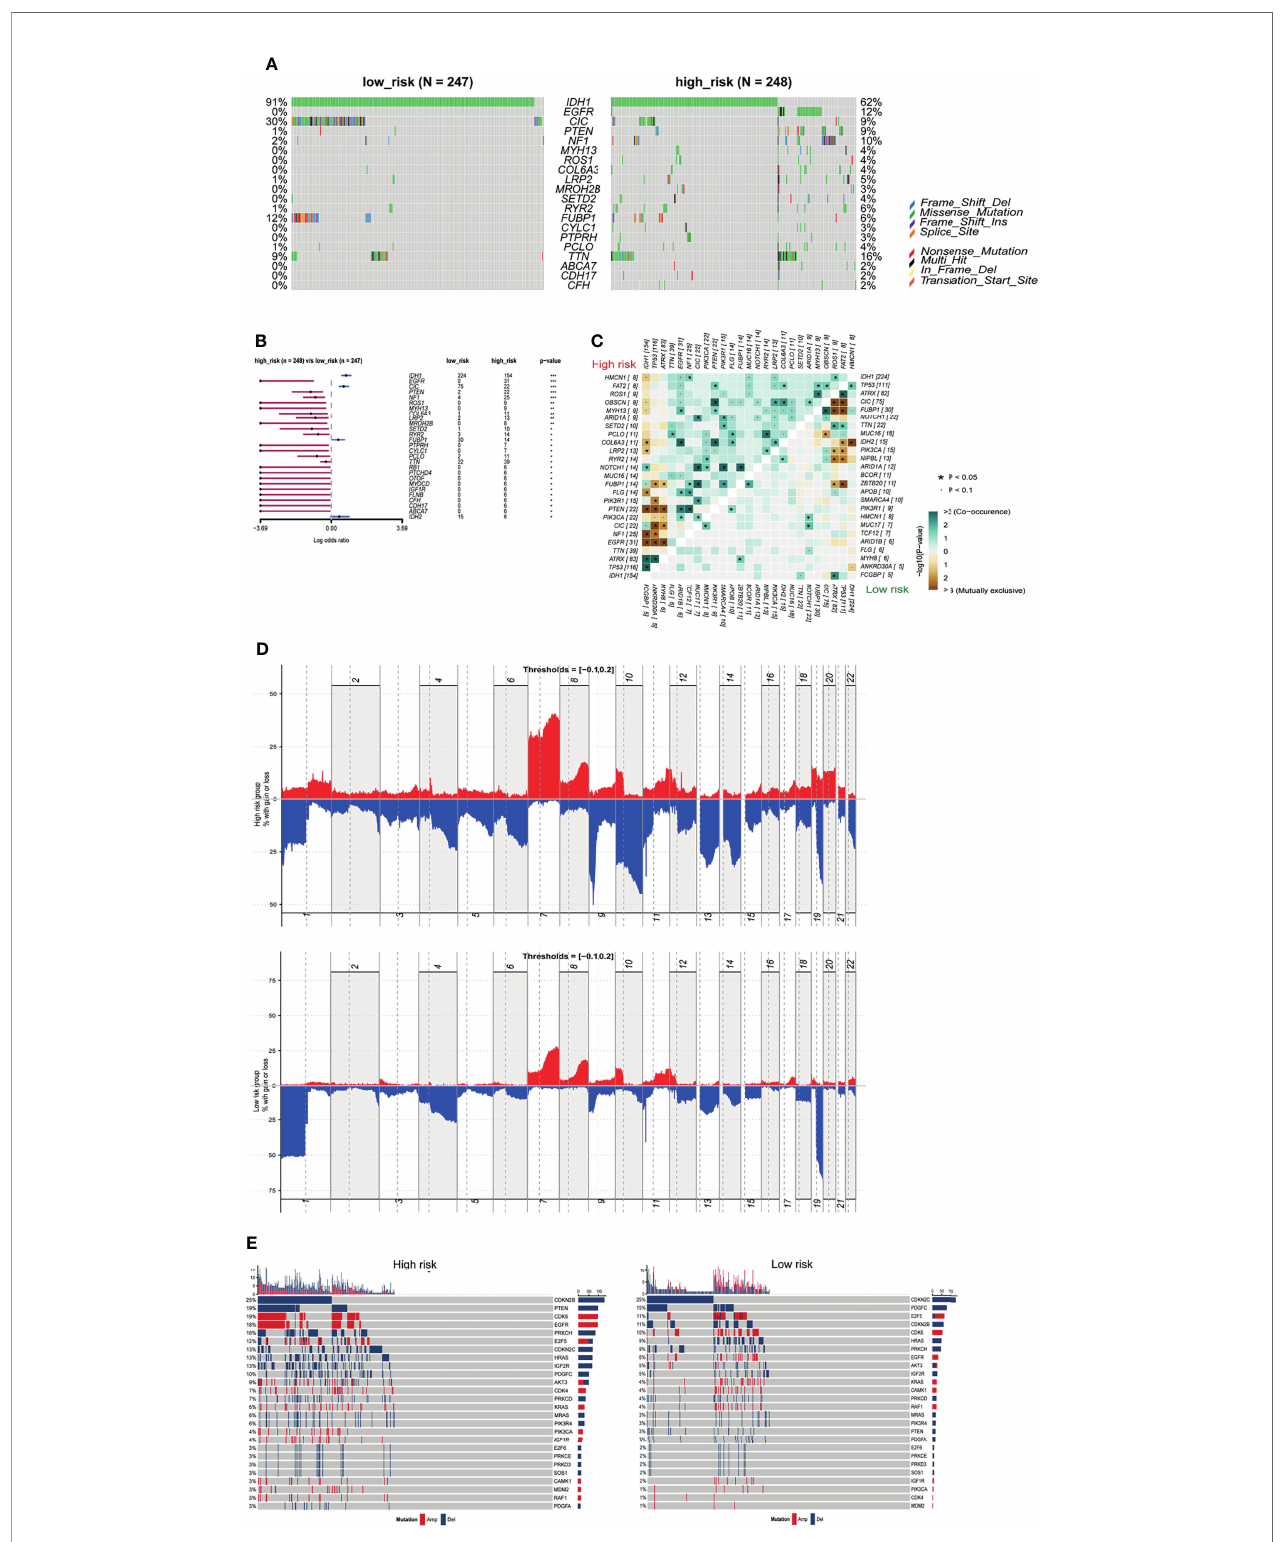
FIGURE 8 | Somatic mutation and CNVs in different risk groups. (A) Seven signi fi cantly different mutated driver genes between high and low risk groups. (B) Forest plot of differentially mutated genes between high and low risk groups. (C) Heatmap of mutually exclusive and co-occurrent mutated genes in high and low risk groups. (D) Distribution of copy number variations in high and low risk groups. (E) Differential CNVs of genes in high and low risk